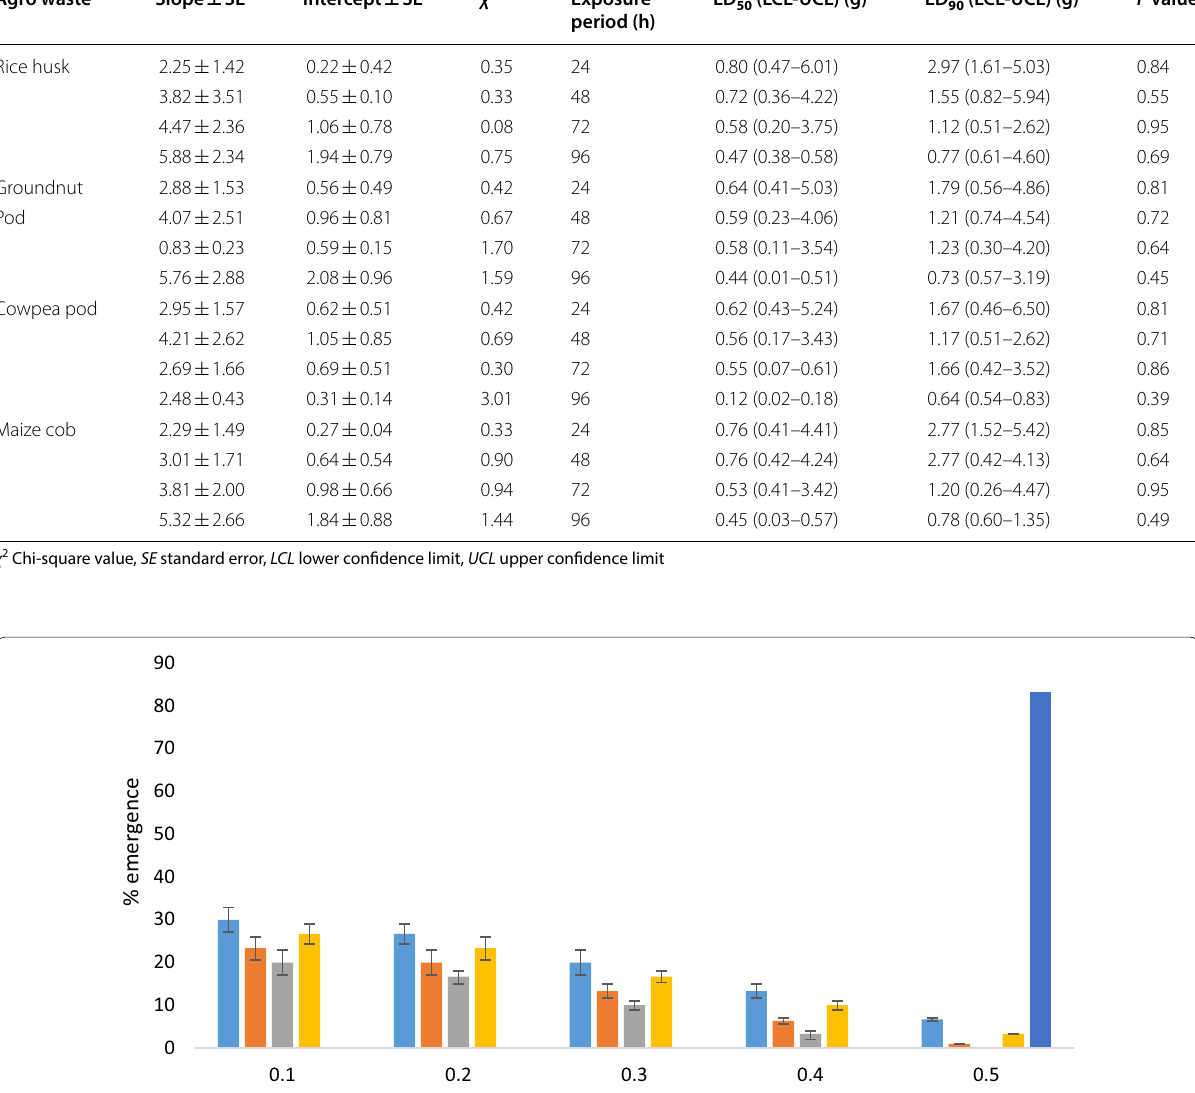
Table 2 Lethal dose (LD) of adult S. cerealella treated with agro waste powders Agro waste